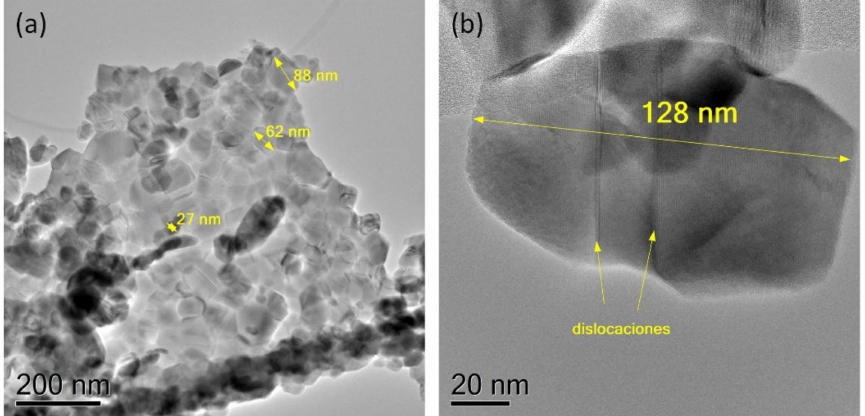
Figure 5. ( a ) TEM images taken of a CuO grain composed of crystallite conglomerates and synthesized by the 2:1 pH8 synthesis route. ( b ) HRTEM image taken of a CuO crystallite with